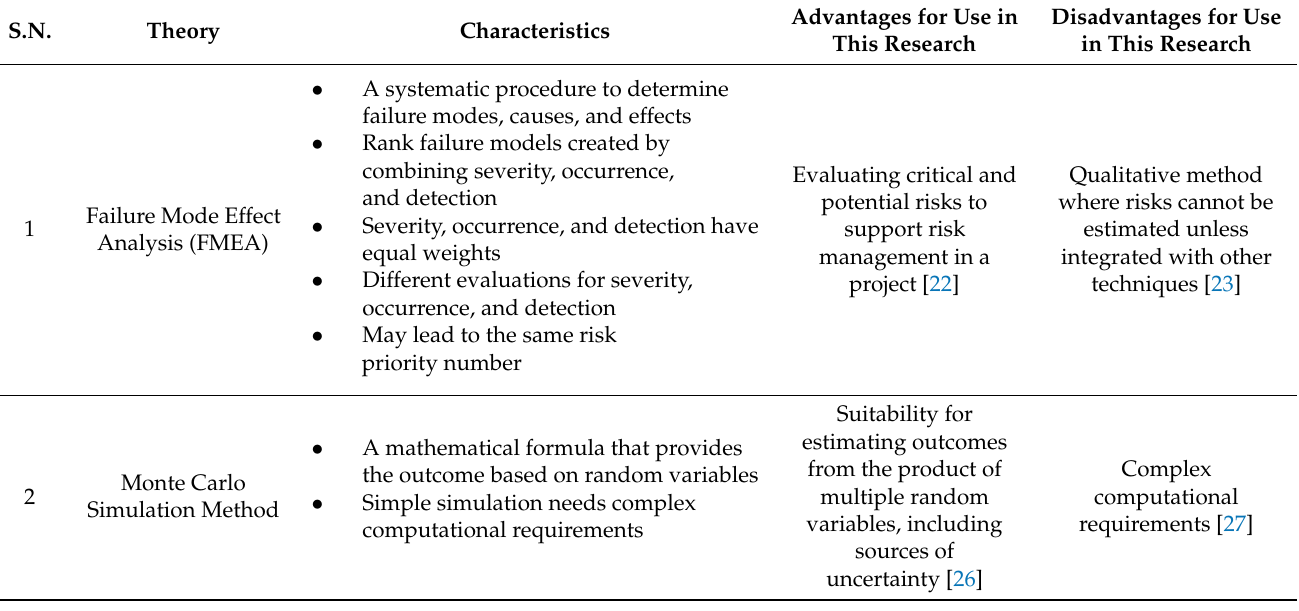
Table 1. Summary of potential methods for risk